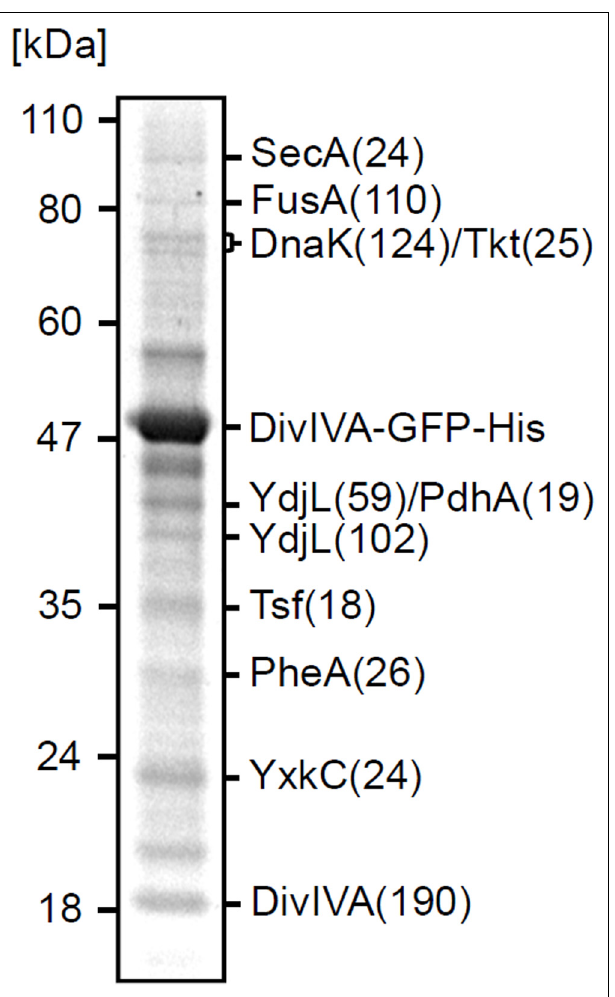
FIGURE 1 | Cross-linking of SecA and DivIVA. Separation by SDS-PAGE of the pull-down fraction obtained with DivIVA-GFP-His as bait.The identity of protein bands and the molecular weight marker are indicated.Total score values (Mascot Scores) of the protein identifications are indicated in